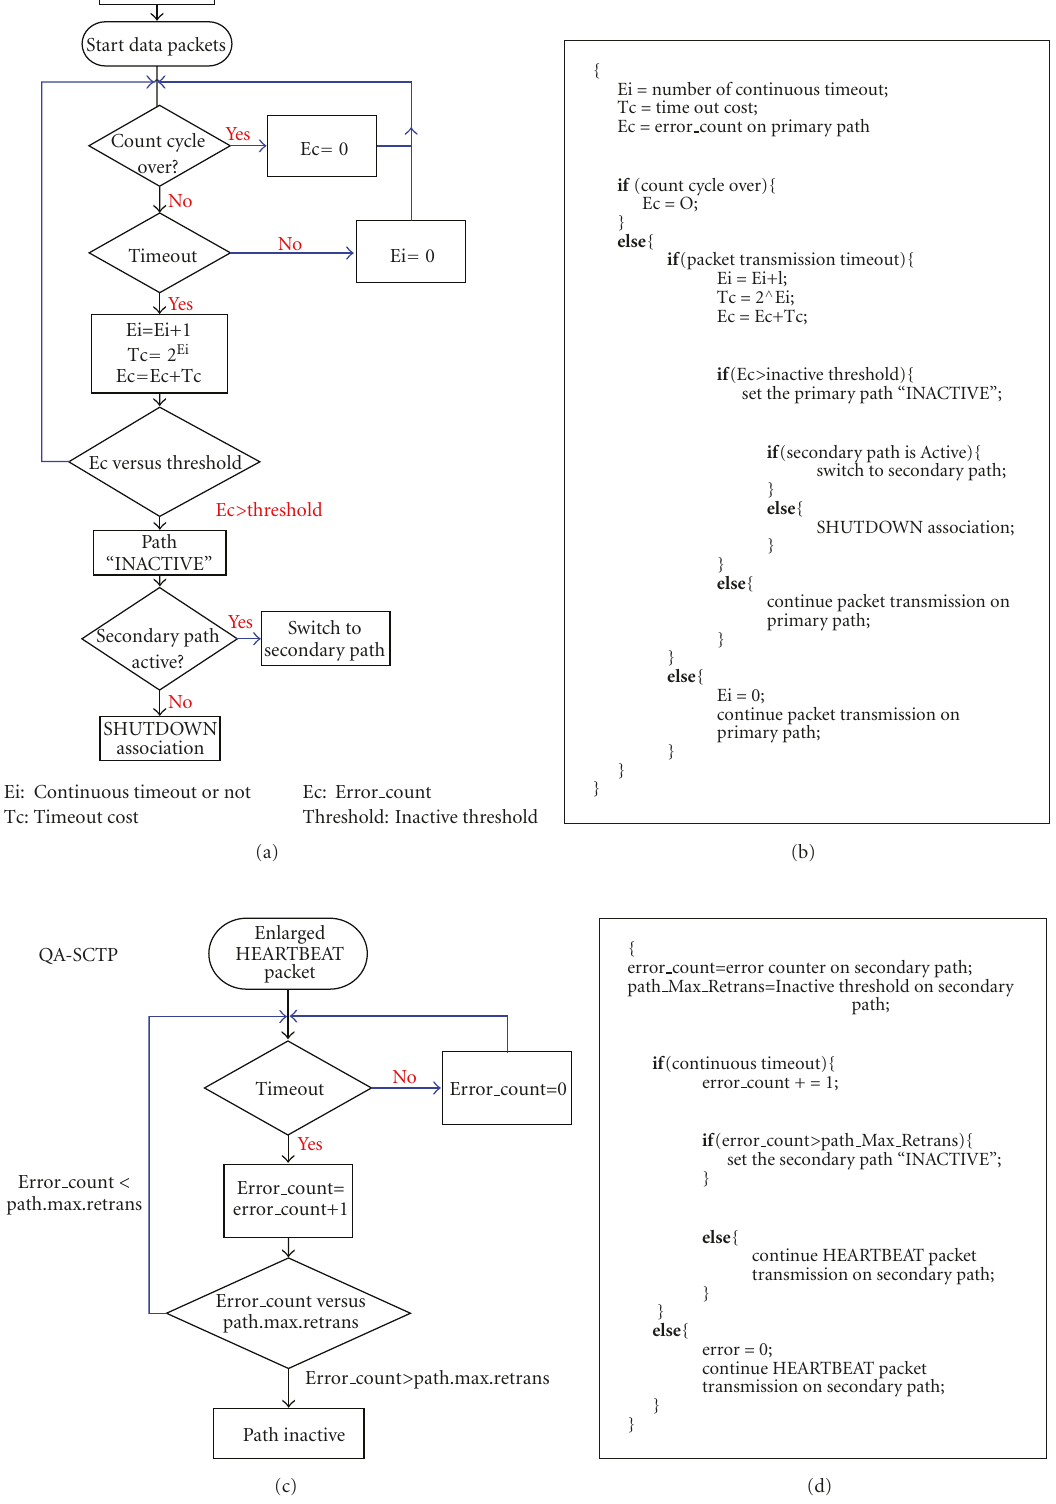
Figure 7: (a) and (b) Primary path, (c) and (d) Secondary path. Path failure detection mechanism